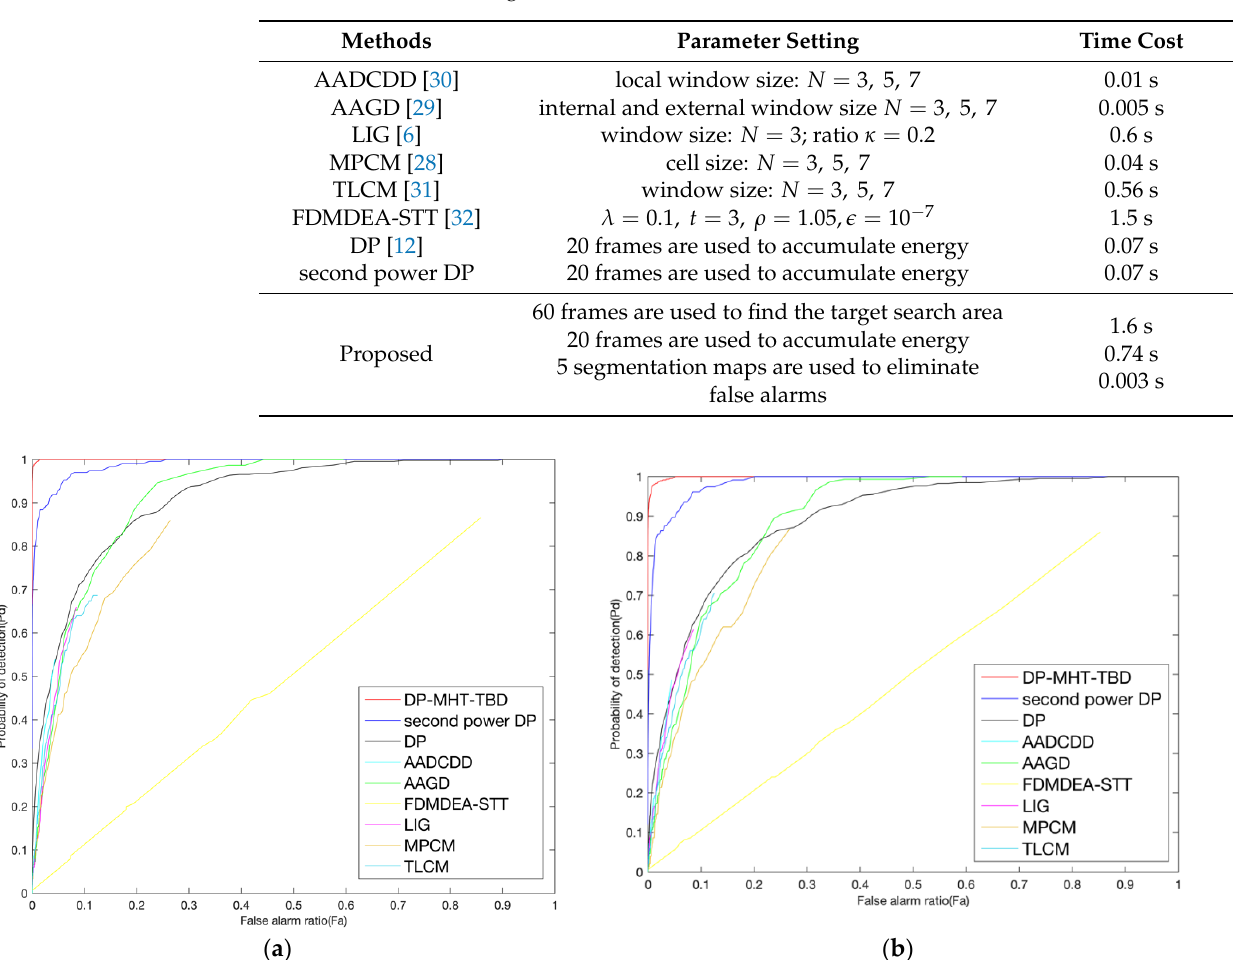
Figure 11. Detection results of the different methods. ( a ) 3-D display of the input image; ( b ) 9 × 9 neighborhoods of the target; ( c ) input image, SCR is 1.5; ( d – g ) are CFAR segmentation maps of dif- ferent methods: ( d ) two stage MHT; ( e ) second power DP; ( f ) DP; ( g ) AAGD; ( h ) final result of DP– MHT–TBD. In the CFAR segmentation process, 𝐹 (cid:3028) = 0.01% . From the results, it can be seen that: (1) The proposed DP–MHT–TBD is superior to other methods with respect to the detection probability and false alarm rate. The proposed second power DP has better per- formance than the original DP. (2) The proper energy accumulation method is the key to the detection of dim point targets. Only the proposed DP–MHT–TBD can detect the target because the energy of the